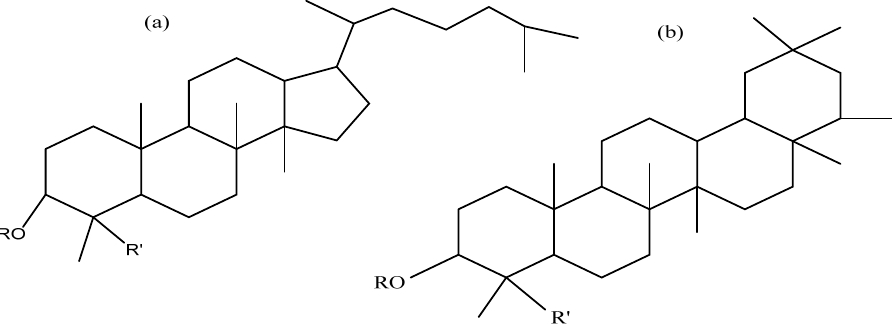
Figure 1. Structures of sapogenins: a steroid ( a ) and a triterpenoid ( b ).